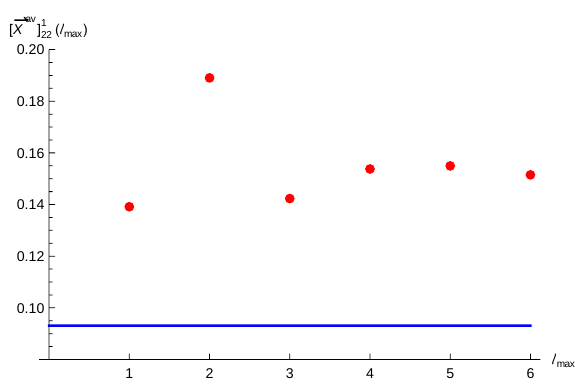
(cid:2) ~X av (cid:3) 1 Figure 10 . Red dots show ( ‘ max ) in the range [0 : 08 ; 0 : 20] plotted against ‘ max . Blue 22 horizontal line at 0 : 0931172 represents the KZ result.